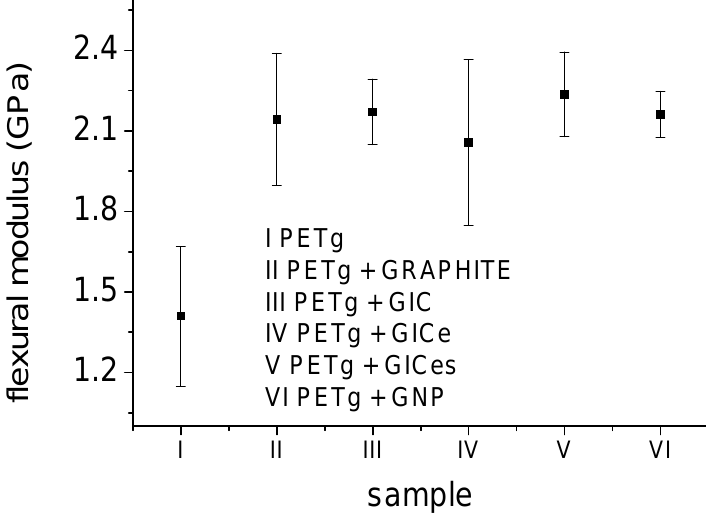
Figure 6. Flexural modulus for PETg and its